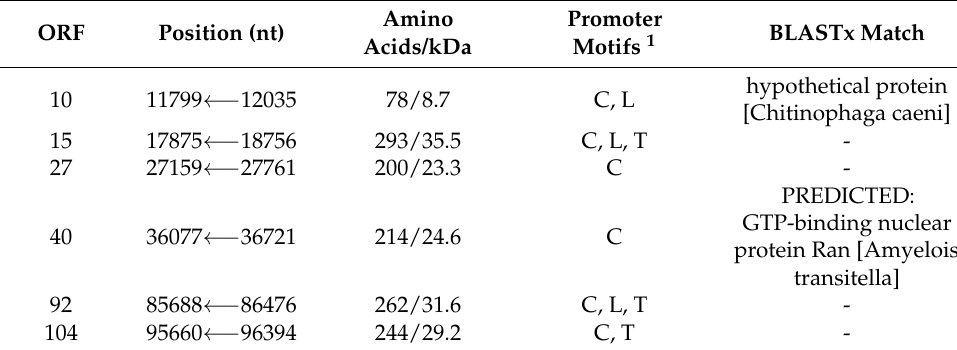
Table 1. Annotated ORFs unique to the PastNPV-473